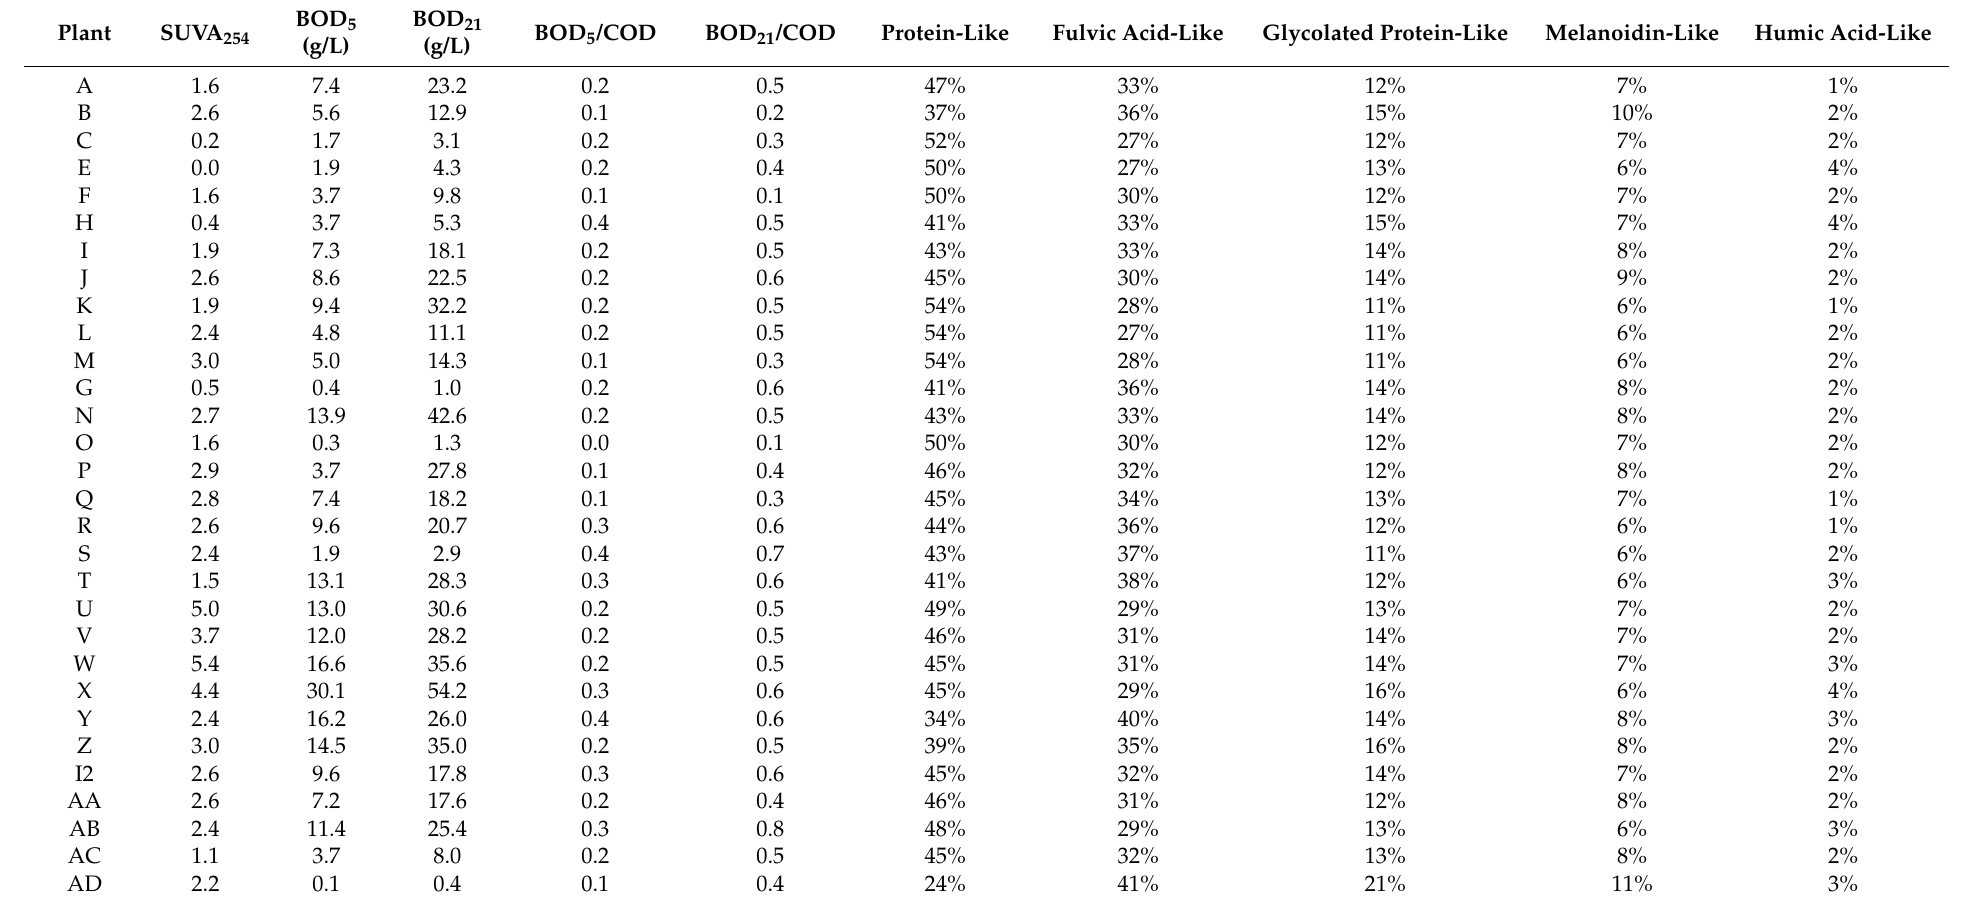
Table A4. SUVA 254 , BOD 5 , BOD 21 , BOD 5 /COD, BOD 21 /COD, protein-like, fulvic acid-like, glycolated protein-like, melanoidin-like, humic